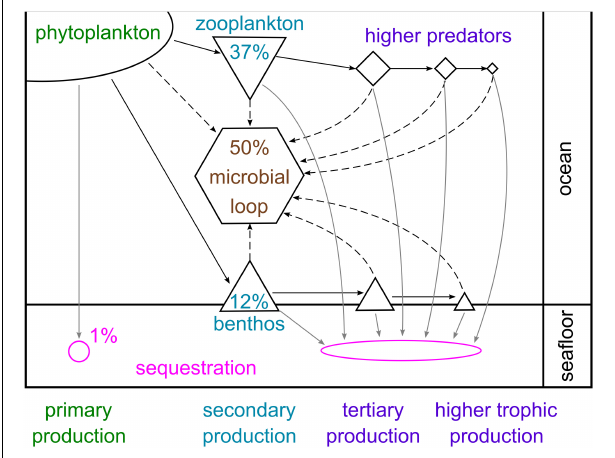
FIGURE 8 | Schematic representation of carbon flows through pelagic and benthic food webs in the Southern Ocean. The percentages given represent approximate mean proportions of total primary production sequestered in the sea floor, broken down via the microbial loop and consumed by zooplankton and benthic consumers, based on several studies from high-productivity shelf environments and the wider literature (Azam, 1998; Ducklow et al., 2007; Hill et al., 2012; Garzio et al., 2013; Sailley et al., 2013; Ballerini et al., 2014; Murphy et al., 2016; Barnes,